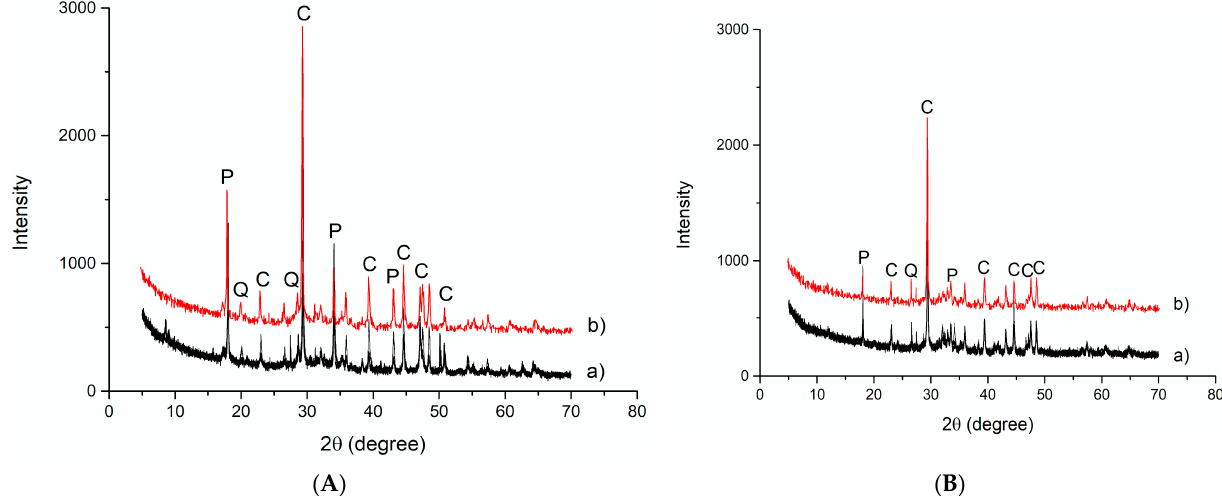
Figure 3. XRD patterns collected on ( A ) carbonated slag and ( B ) desulfurization slag before (a) and after (b) NaOH 8M test (C = calcite; P = portlandite; Q = quartz).